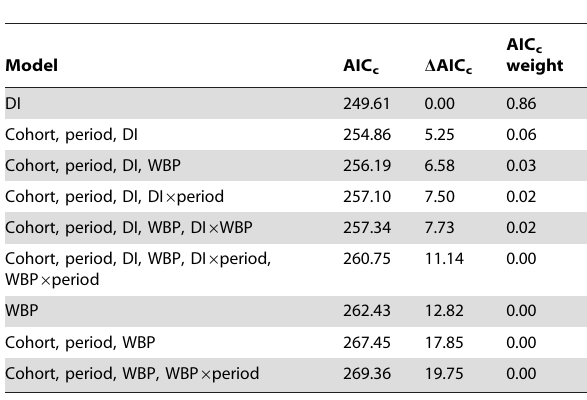
Table 4. Akaike’s Information criteria (AIC c ) of linear mixed- effects model 1 to examine relationships of covariates 2 with home-range size (km 2 ; minimum convex polygon) of female grizzly bears in the Greater Yellowstone Ecosystem.